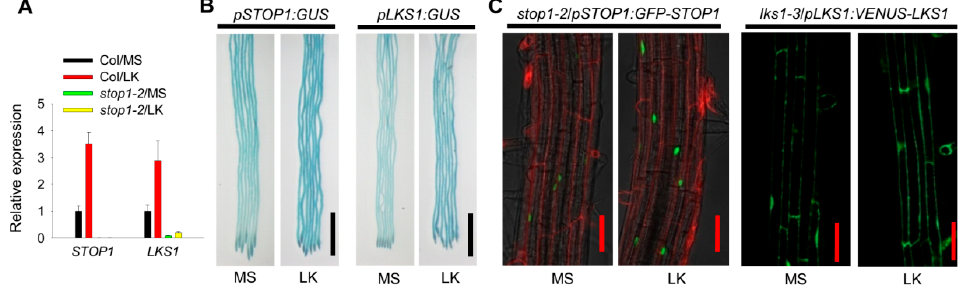
Figure 7. The expression of both STOP1 and LKS1 is induced after low-K + stress. ( A ) RT-qPCR analyses of STOP1 and LKS1 expression in wild type (Col) and stop1-2 mutant after LK stress. The 5 day old seedlings were transferred to MS or LK medium for 1 day. Then, the roots were collected and used for RT-qPCR assays. Data are means ± SE ( n = 4). ( B ) GUS staining analyses of STOP1 and LKS1 expression after LK treatment. The 5 day old seedlings were transferred to MS or LK medium for 1 day, and then used for GUS staining. Scale bars = 2 mm. ( C ) Fluorescence observation showing the protein expression of GFP-STOP1 and VENUS-LKS1 after LK stress. The red fluorescence was due to the propidium iodine staining. The 5 day old seedlings were transferred to MS or LK medium for 1 day, and then used for fluorescence observation. Scale bars = 50 µ